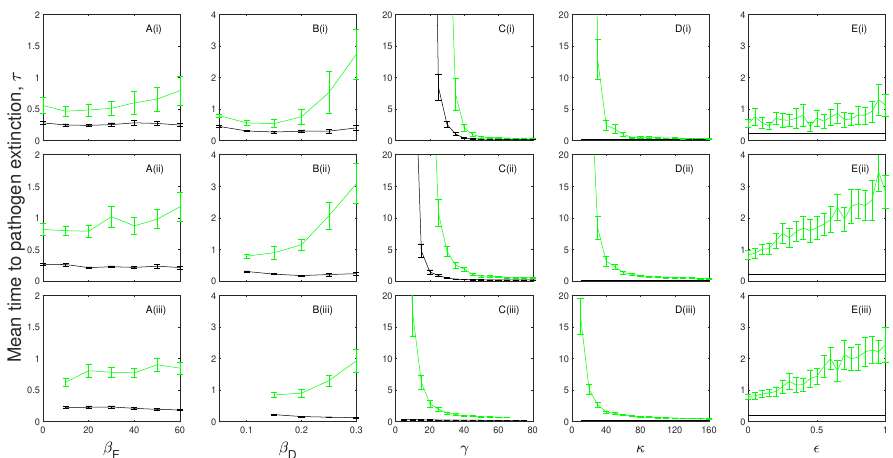
Figure 4. A parameter sensitivity analysis for the SIR (black) and SEIR (green) model frameworks and where in ( i ) α = 10, ( ii ) α = 40 and ( iii ) α = 80. The mean time to pathogen extinction (with 95% confidence intervals) is plotted against ( A ) the frequency-dependent transmission rate, β F ; ( B ) the density-dependent transmission coefficient, β D ; ( C ) the infected recovery rate, γ ; ( D ) the exposed rate, κ ; and ( E ) the exposed infectiousness, (cid:101) . When not changed in the figure baseline parameter values were used (see Table 2).